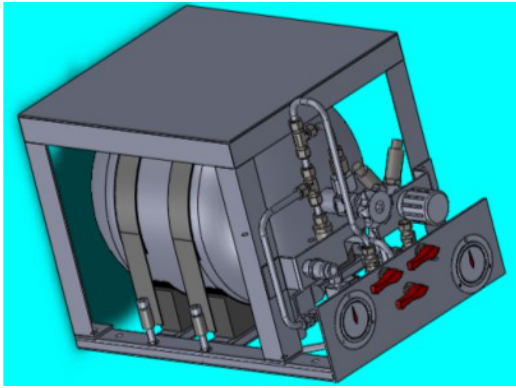
Figure 3. Hydrogen supply system.